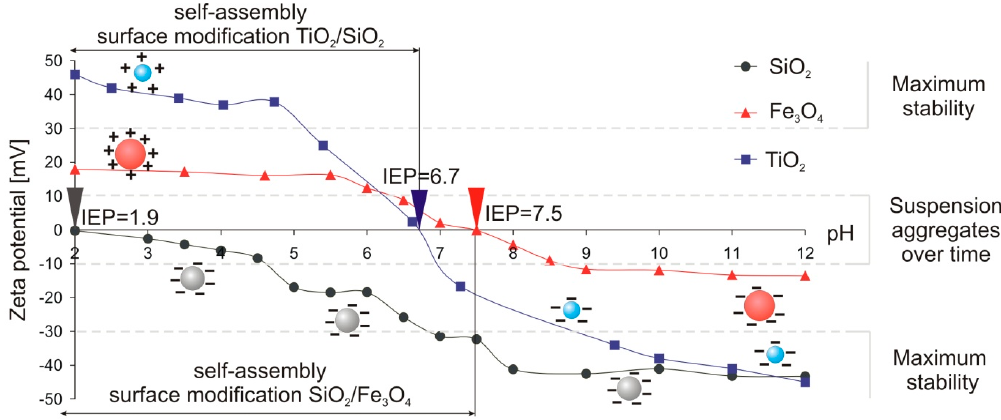
Figure 2. Zeta potential of Fe 3 O 4 , SiO 2 and TiO 2 nanoparticles as a function of pH.